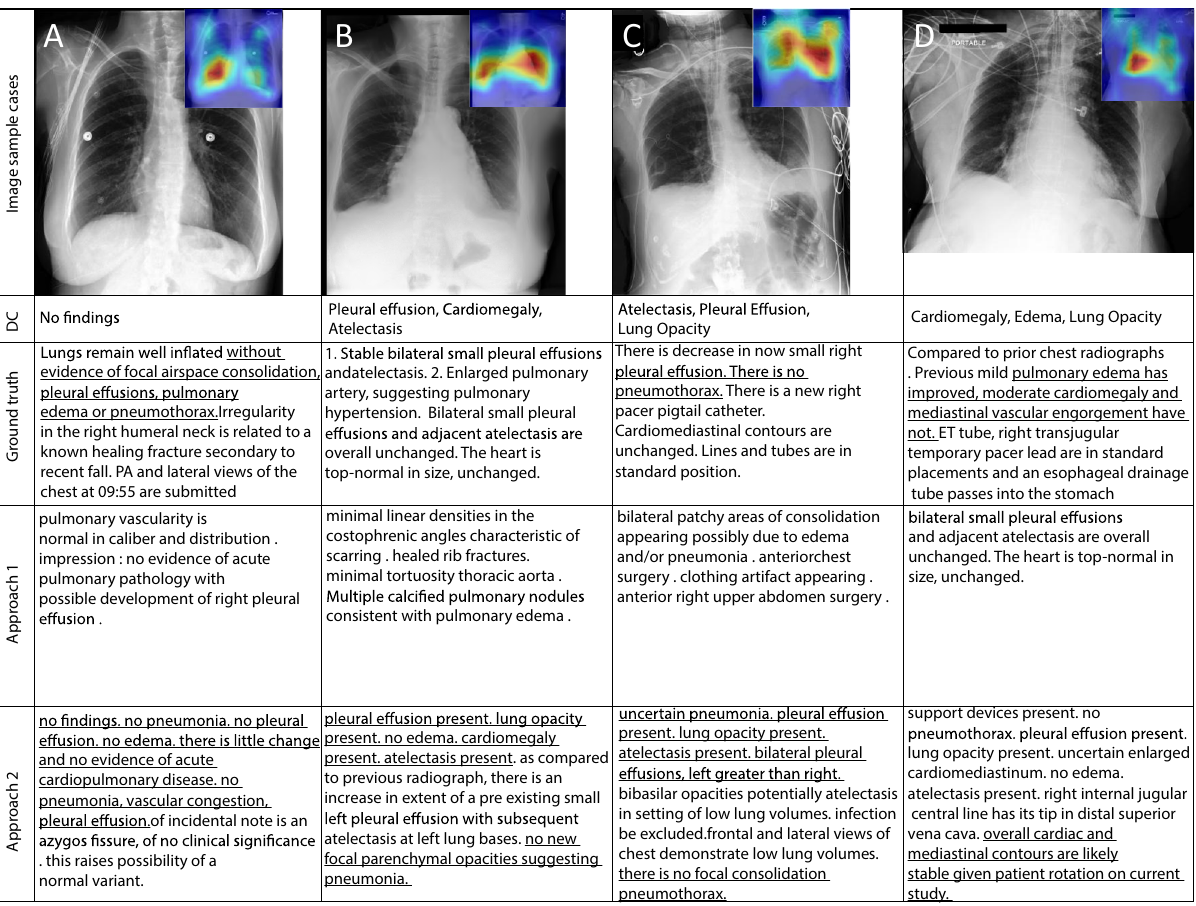
Figure 4. Image sample cases with the disease classes (DC) along with original (ground truth) and generated reports by the proposed SAT + GPT-3 model implemented as in Approach 1 and 2, respectively. Insets in the upper corners of the original images feature localization heatmaps. Heatmaps are generated using Matplotlib v.3.7.0 64